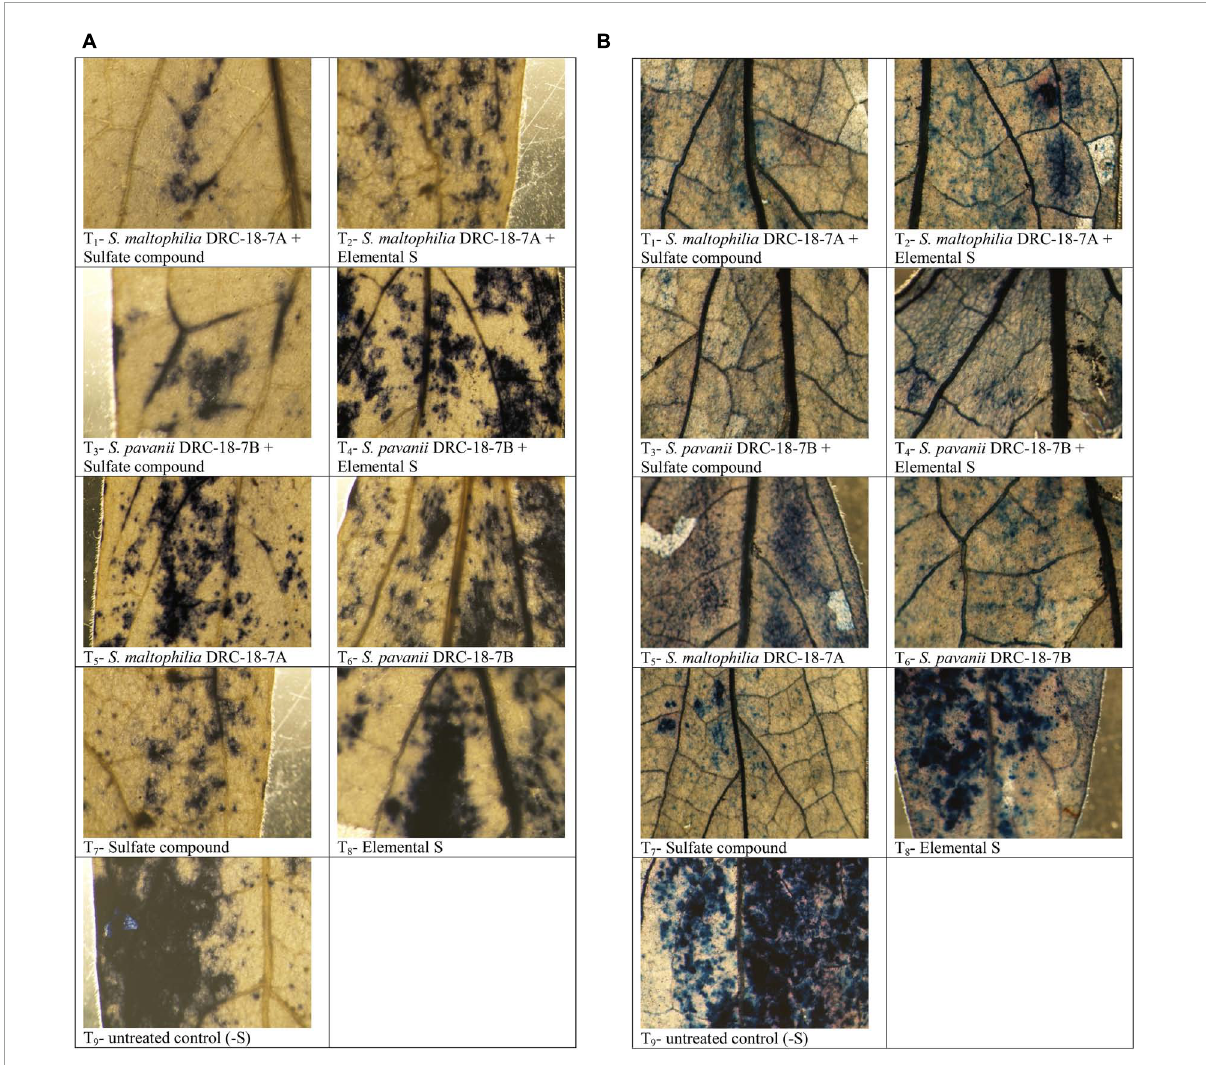
FIGURE8 Microscopic detection of superoxide radical by NBT staining (A) and program cell death (B) in leaves of pigeonpea after treatment with T 1 - Stenotrophomonas maltophilia DRC-18-7A + Sulfate compound, T 2 - S maltophilia DRC-18-7A + Elemental S, T 3 - S. pavanii DRC-18-7B + Sulfate compound, T 4 - S. pavanii DRC-18-7B + Elemental S, T 5 - S. maltophilia DRC-18-7A, T 6 - S. pavanii DRC-18-7B, T 7 -Sulfate compound, T 8 -Elemental S and T 9 -untreated control (-S) at 30 days of